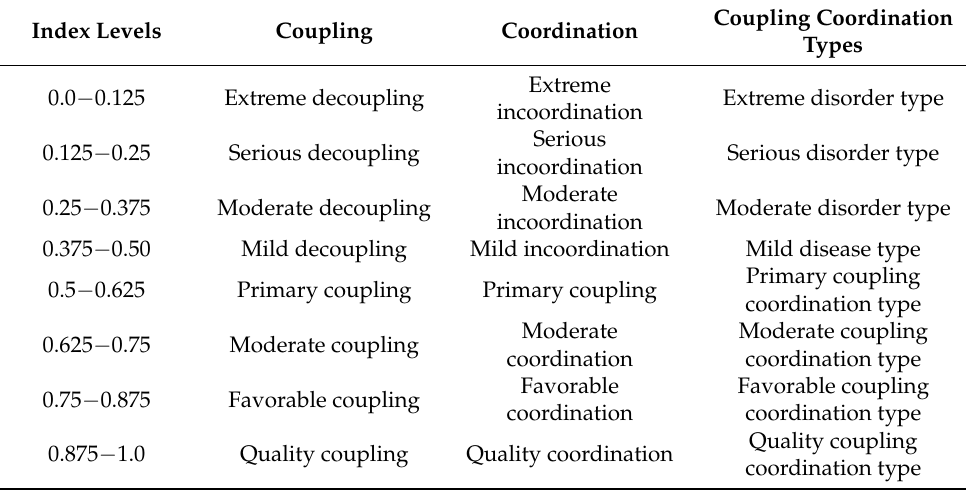
Table 2. Classification of the coupling coordination degree